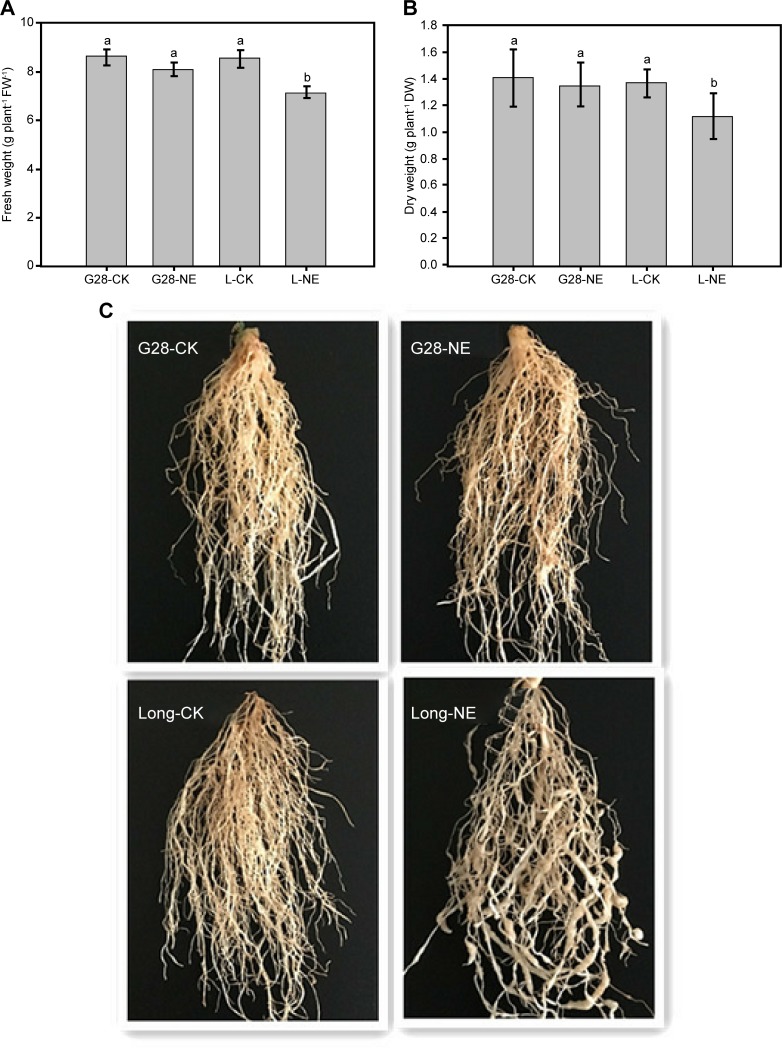
Phenotypic traits of G28 and Long bohuang.(A) fresh weight. (B) Dry weight. (C) Symptoms of nematode infection.